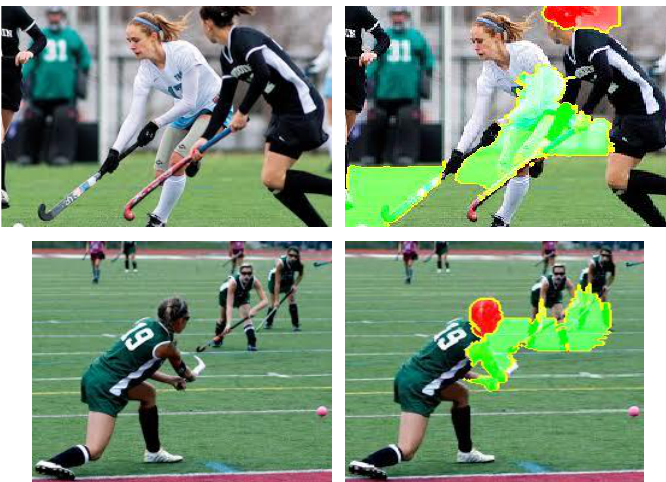
Figure 8. Examples of how LIME explained classifying images as field hockey. The hockey sticks are decisive for classification, while general features, such as faces and hair, do not contribute.